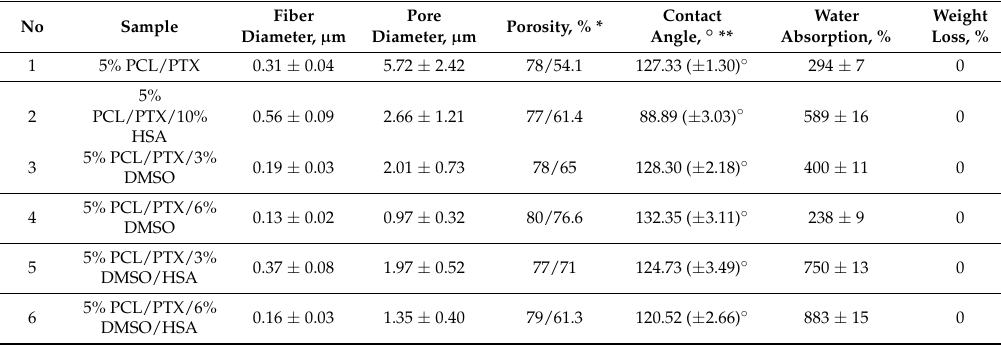
Table 2. Physico-chemical properties of 3D